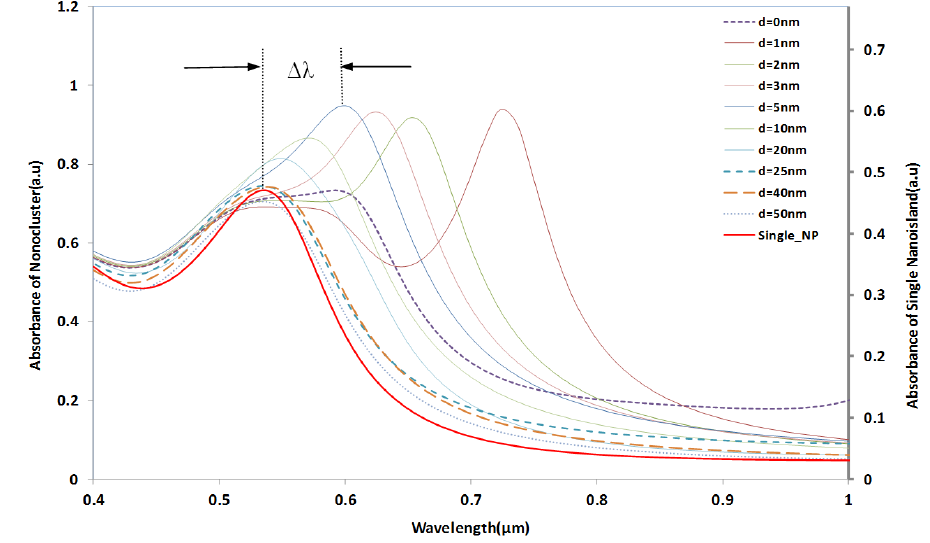
Figure 4. LSPR spectrum of the gold nano-hemisphere against the particle separation distance d .